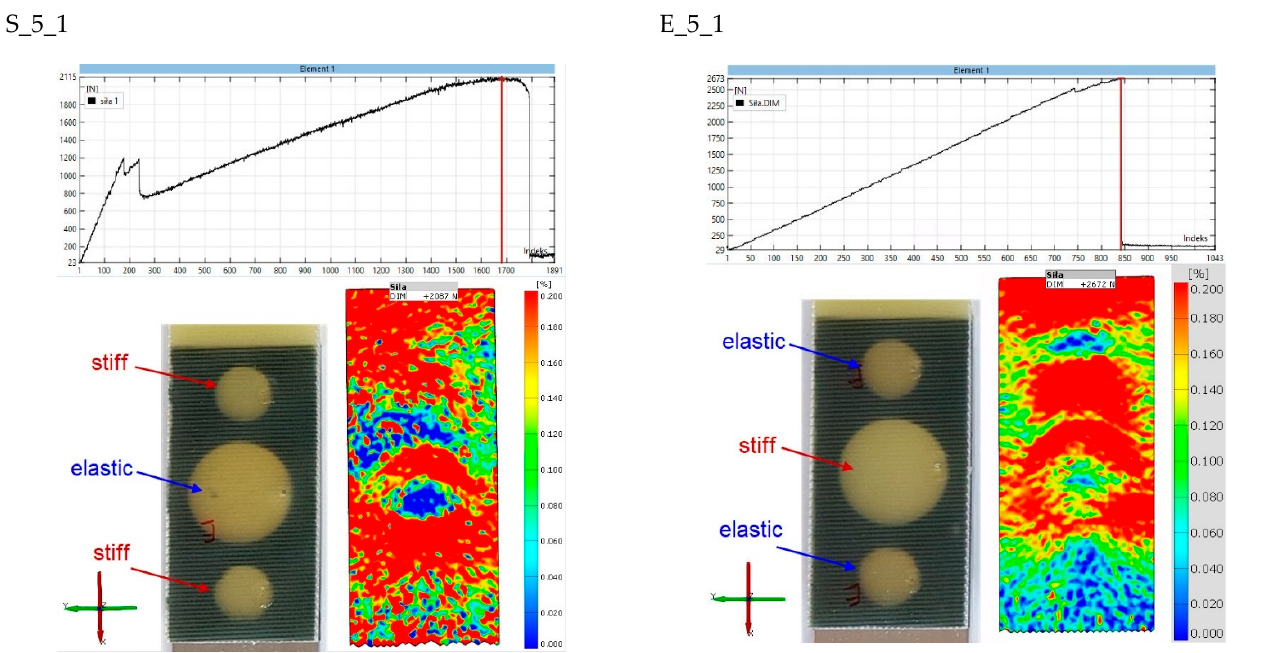
Figure 21. Comparison of principal strain maps for “S” and “E” batch 5 specimens for maximum force in the second stage of operation.